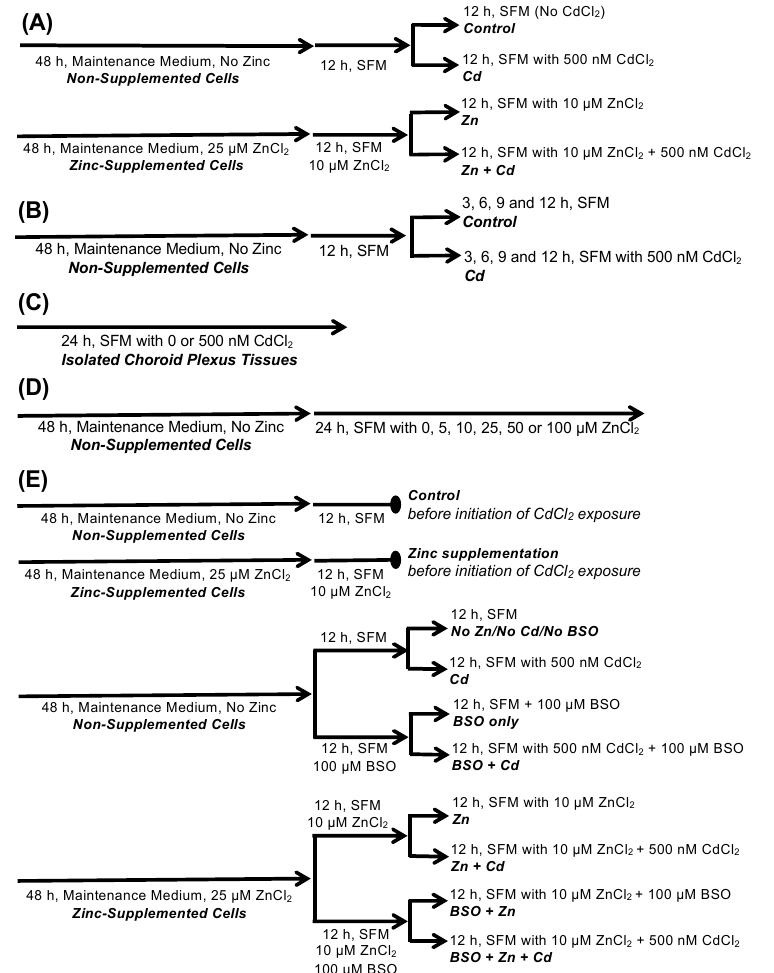
Figure 1. Schematic outlines for experimental treatments of choroid plexus epithelial cells (CPECs) or isolated choroid plexus (CP) tissues with cadmium (Cd), zinc (Zn), and L - buthionine sulfoximine (BSO). ( A ) CPECs were incubated (48 h) in maintenance medium with 0 or 25 µ M ZnCl 2 to prepare non-supplemented versus Zn-supplemented cells, respectively. Non-supplemented cells were then pretreated (12 h) in serum-free medium (SFM) before 12 h exposure in SFM to either 0 or 500 nM CdCl 2 ; Zn-supplemented cells were pretreated (12 h) in SFM with 10 µ M ZnCl 2 before 12 h exposure in SFM with 10 µ M ZnCl 2 and either 0 or 500 nM CdCl 2 . ( B ) Non-supplemented CPECs were prepared and pre-treated (12 h, SFM) before 12 h exposure in SFM with either 0 or 500 nM CdCl 2 ; cadmium and time-matched control cells were collected at 3, 6, 9, and 12 h. ( C ) CP tissues from neonatal rats were isolated and incubated (24 h) in SFM with 0 or 500 nM CdCl 2 . ( D ) Non-supplemented CPECs were prepared and then incubated (24 h, SFM) with 0-100 µ M ZnCl 2 . ( E ) Non-supplemented and Zn-supplemented CPECs were prepared and exposed to cadmium in the absence or presence of BSO, an inhibitor of glutathione synthesis. Representative non-supplemented and Zn-supplemented cells were treated (12 h) in SFM without or with 10 µ M ZnCl 2 respectively, but not subjected to further treatment. Other cells were treated as follows. In absence of BSO, a group of non-supplemented cells was pre-treated (12 h, SFM) and then exposed (12 h) in SFM to either 0 or 500 nM CdCl 2 . In absence of BSO as well, a group of Zn-supplemented cells was pre-treated (12 h, SFM) with 10 µ M ZnCl 2 and then exposed (12 h) in SFM with 10 µ M ZnCl 2 to either 0 or 500 nM CdCl 2 . In the presence of BSO, another group of non-supplemented cells was pre-treated (12 h) in SFM with 100 µ M BSO and then exposed (12 h) in SFM with 100 µ M BSO to either 0 or 500 nM CdCl 2 . In the presence of BSO as well, a group of Zn-supplemented cells was pre-treated (12 h) in SFM with 100 µ M BSO and 10 µ M ZnCl 2 and then exposed (12 h) in SFM with 100 µ M BSO and 10 µ M ZnCl 2 with either 0 or 500 nM CdCl 2 . All treatments were performed at 37 ◦